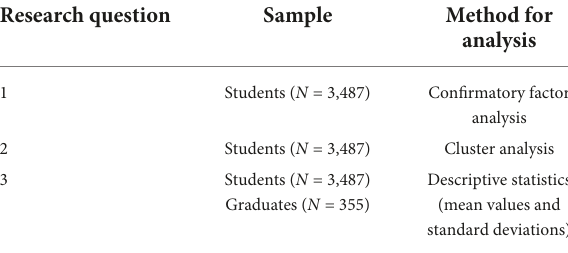
TABLE 3 Methods of analysis and samples used according to the three research questions. Research